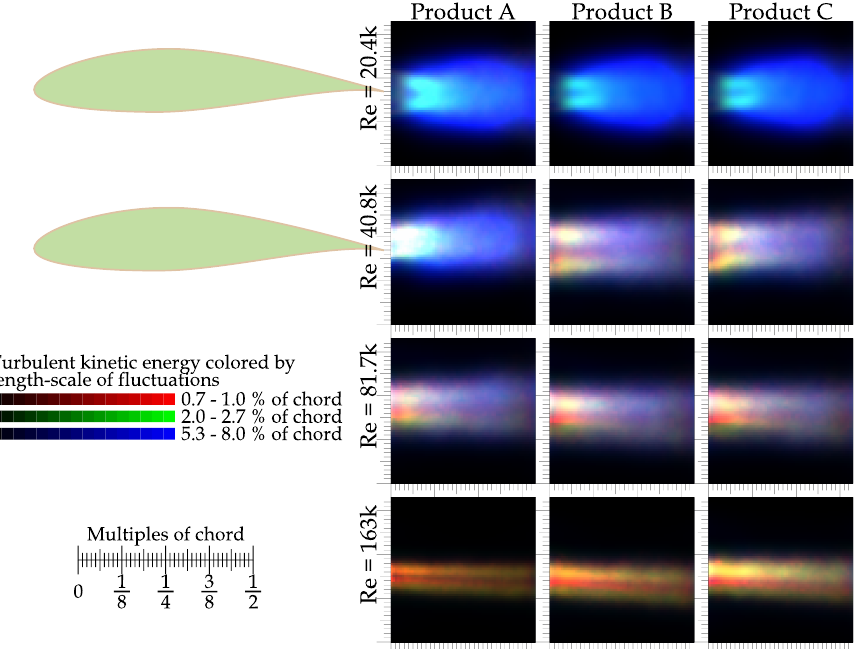
Figure 14. Turbulent kinetic energy colored by the length-scale of fluctuations producing it at angle of attack α = 0 ◦ . TKE is divided into three channels: the red channel represents fluctuations of sizes 0.7–1.0% of chord width; the green channel shows fluctuations of sizes between 2.0% and 2.7% of chord width; while the blue represents the largest fluctuations of sizes 5.3–8.0% of chord width. The color scale for different color channels is normalized in such a way that an ideal Kolmogorov turbulence would be displayed in shades of gray. Among different Re and variants, the color scale is automatically adapted (for differences in amount of TKE, look to Figure 13 or Figure